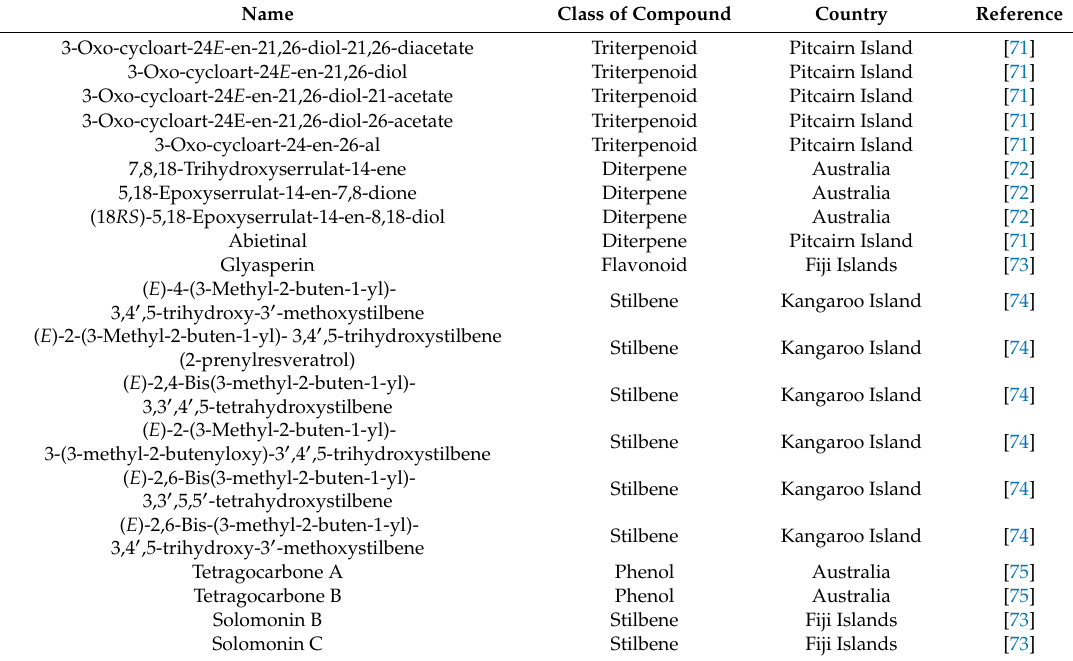
Table 4. Some compounds isolated from Australian propolis between 2015 and